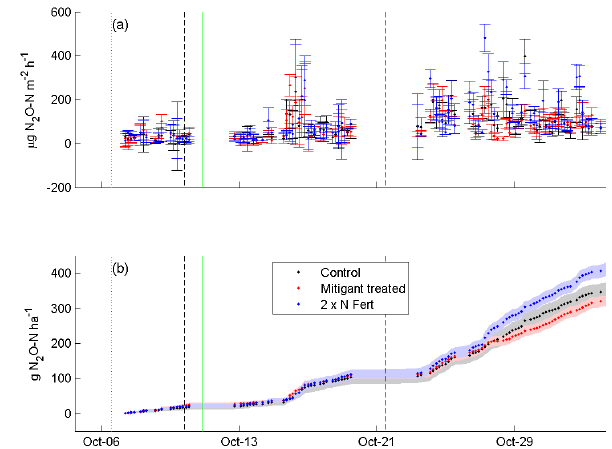
Fig. 9. N 2 O fluxes averaged over 4h intervals (a) and cumulative N 2 O fluxes over corresponding interval with error bounds indicated by shaded regions (b) . The dashed vertical lines indicate the timing of grazing (black), double or single (control) N fertilisation (green) and dicyandiamide application (red). Note the use of different y axis units between the upper and lower